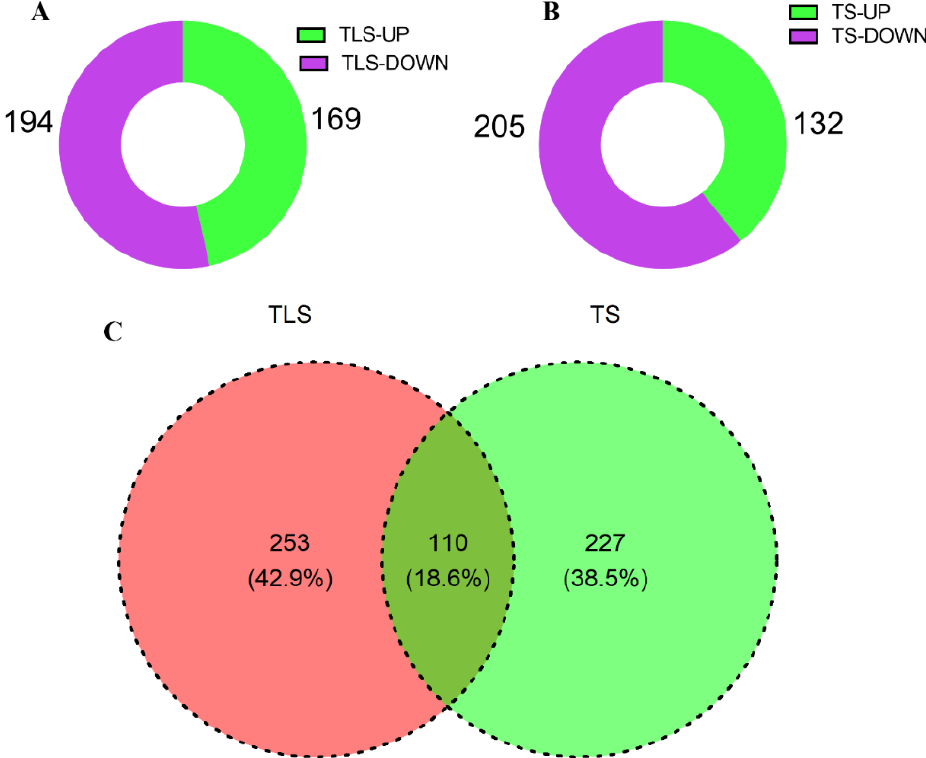
Figure 2. Statistical analysis of DAPS of spaceflight in different growth stages of rice progeny. ( A ) represents the DAPs at the TLS; ( B ) represents the DAPs at the TS; ( C ) represents the Venn diagram of the DAPs at the TLS and the TS. TLS and TS stand for three ‐ leaf stage and tillering stage, respectively.